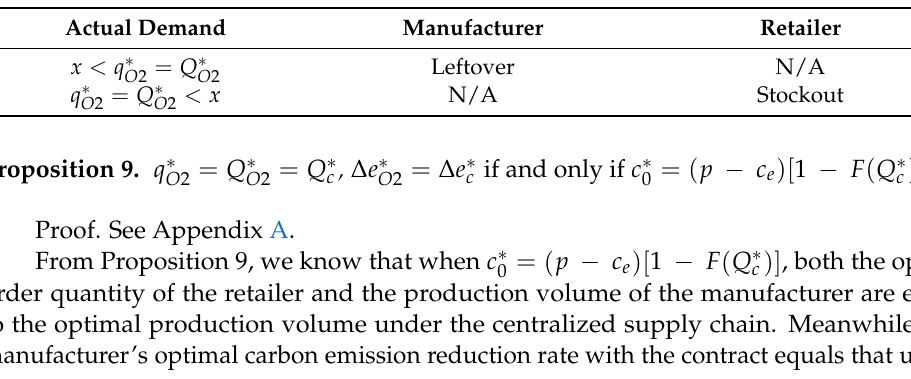
Table 5. Risk-sharing of partners under the option contract